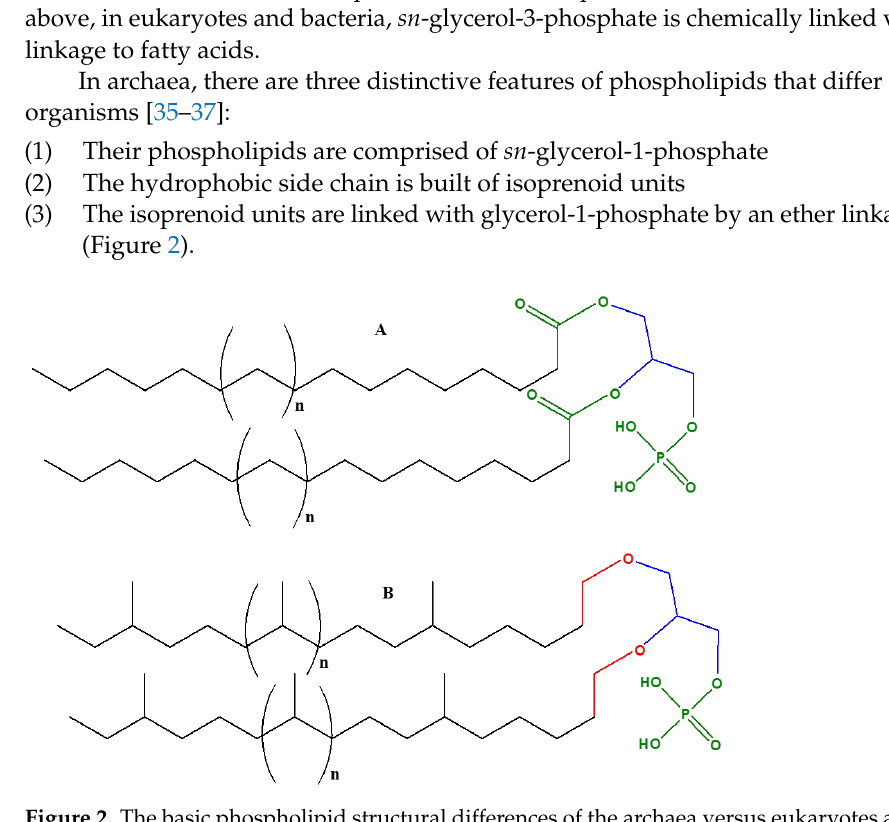
Figure 2. The basic phospholipid structural differences of the archaea versus eukaryotes and bacteria: ( A ) generic structure of phospholipids in most eukaryotes and bacteria that contain unbranched fatty acid chains linked up with sn -glycerol-3-phosphate (D-glycerol). The bond between fatty acids and glycerol phosphate is an ester (shown as green color), ( B ) generic structure of phospholipids in archaea contains ‘branched isoprenoid’ units, linked up with sn -glycerol-1-phosphate (L- glycerol) via ether linkages, shown as red color. “n” represents generic number for the isoprenoid or fatty acid units.